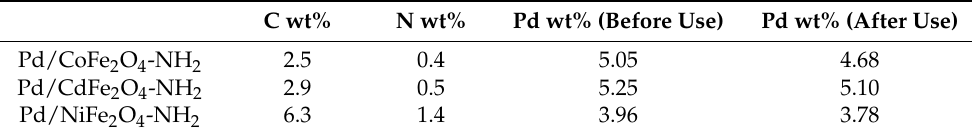
Table 2. Carbon and nitrogen content (based on CHNS elemental analysis) of the catalysts, as well as their palladium content before use and after four catalytic cycles.